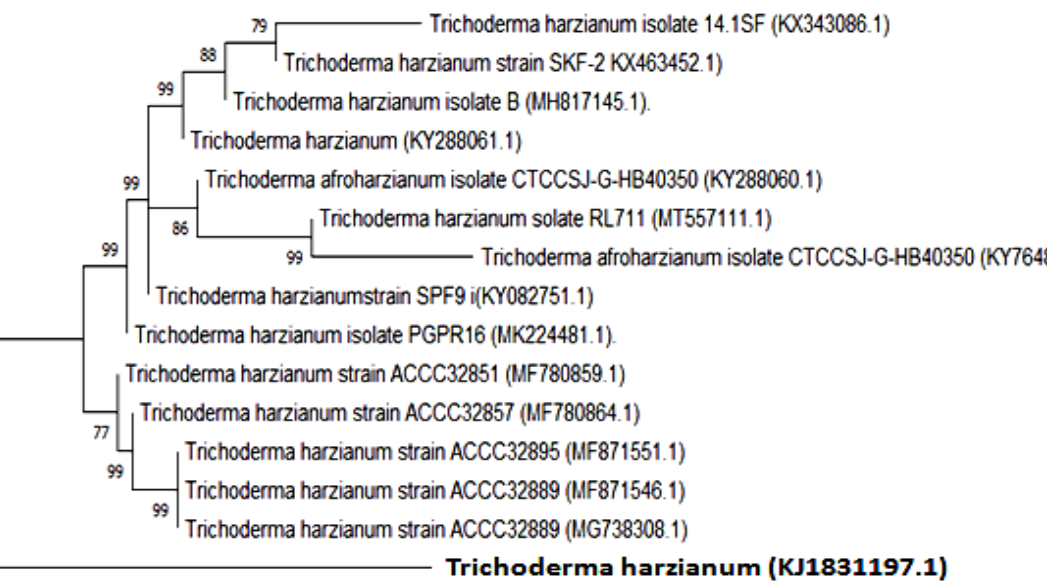
Figure 4. Relation of different incubation temperatures (°C) and pH values to xylanase production by Trichoderma harzianum kj831197.1. Commonly, microbes are acknowledged to yield high levels of enzymes at their op- timal growth temperature. In the current study, 30 °C was the optimum temperature for maximal production of xylanase by Trichoderma harzianum kj831197. (Figure 4). Glucose was observed to exhibit the highest xylanase production when compared with xylose, lactose, and arabinose (Figure 5). To gain a more detailed understanding of the production of xylanase by Trichoderma harzianum kj831197.1, different incubation con- ditions such as static and shaking were carried out. Results in Figure 5 showed that